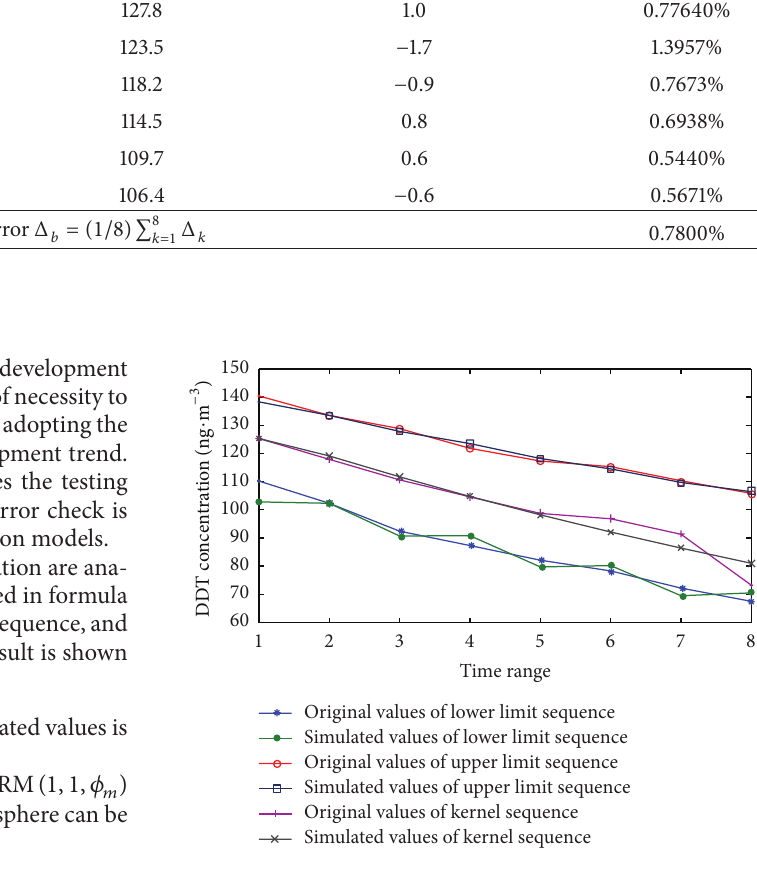
Figure 6: Comparison of original and simulated